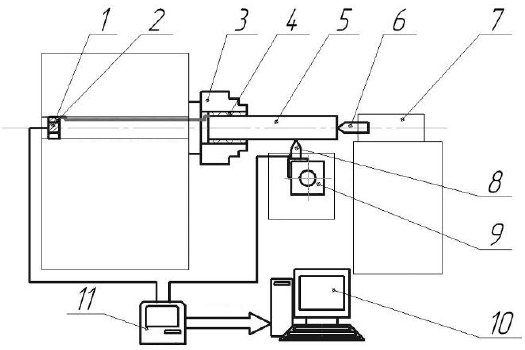
Figure 5. Scheme of temperature measurement by natural thermocouple method: 1 — mercury cur- rent collector; 2, 4 — insulation; 3 — cartridge; 5 — blank; 6 — isolated rear center; 7 — tailstock; 8 — tool collector; 2, 4—insulation; 3—cartridge; 5—blank; 6—isolated rear center; 7—tailstock; 8—tool holder; holder; 9 — a cutter with insulation; 10 — a computer; 11 — a digital voltmeter. 9—a cutter with insulation; 10—a computer; 11—a digital